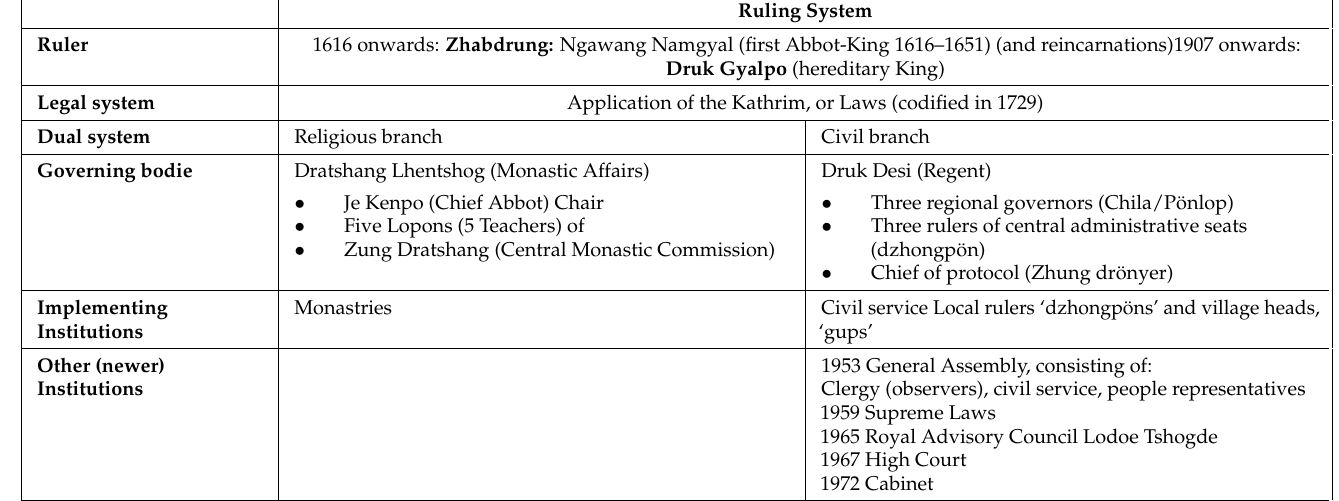
Table 3. Bhutan’s Historic system of governance (adapted from Van Norren